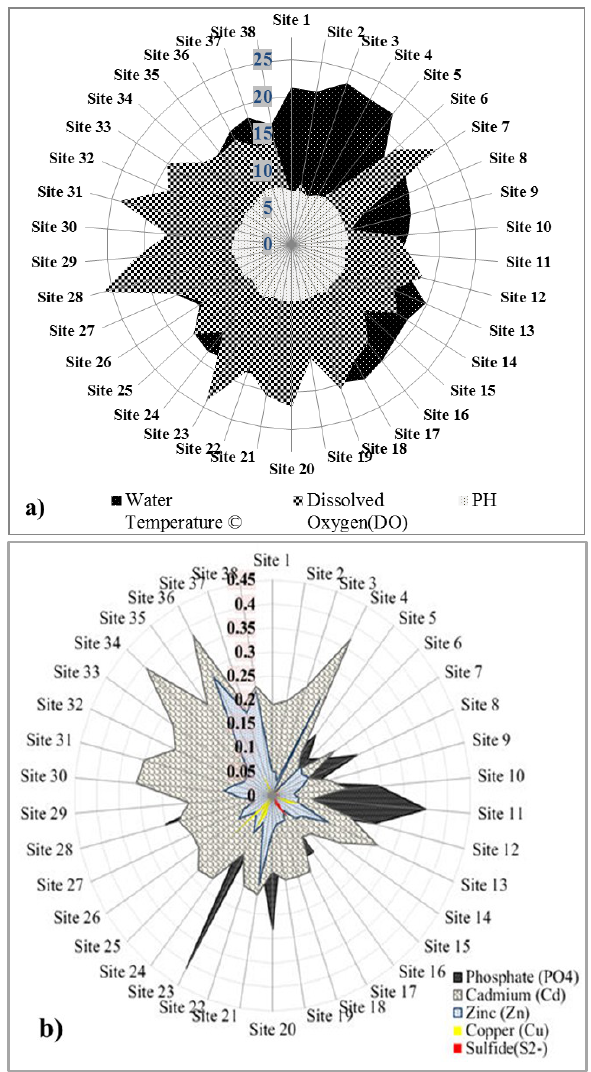
Figure 4. (a) Radar plot of water pH, water temperature (°C), and dissolved oxygen (DO), with water temperature and dissolved oxygen varying inversely. (b) Radar plot showing concentration (mg/L) of phosphate (PO 4) , cadmium (Cd), zinc (Zn 2+ ), copper (Cu 2+ ), and sulphide (S 2− ) as measured in water